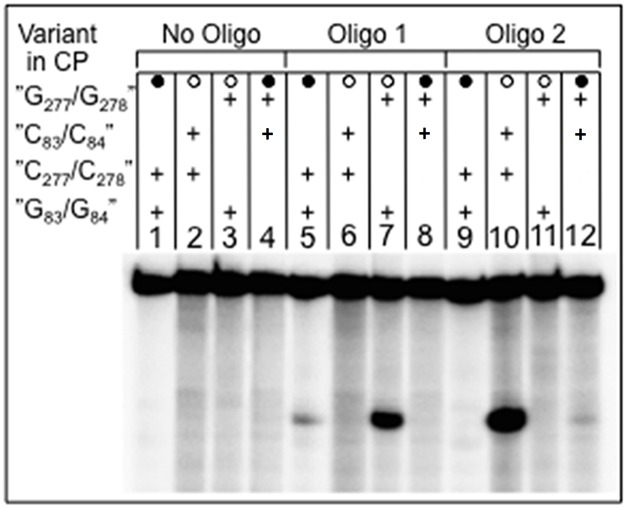
Formation of the "P6-mimic" in Eco CP RPR.Probing the accessibility of residues involved in formation of the "P6-mimic" in Eco CP RPR with RNase H and in the presence of DNA oligo 1 (5'TGCCCT, complimentary to residues (underlined) 5'A81GGGCA86 in Eco CP RPRwt and Eco CP RPRG277G278) and DNA oligo 2 5'TGGGCT, complimentary to residues 5'A81GCCCA86 in Eco CP RPRC83C84 and Eco CP RPRC83C84/G277G278 as indicated. The black circles indicate when the "P6-mimic" can form while open circles refer to when it cannot form. For experimental and other details see text.